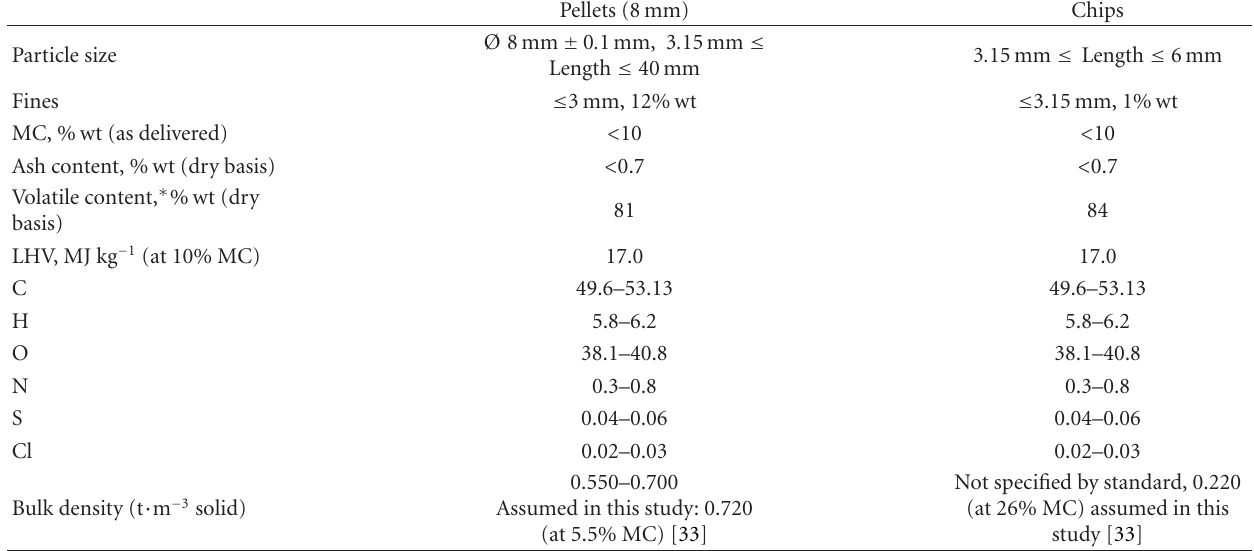
Table 1: Properties of pellets and chips according to standard [16] and the Fuel Handbook [55]. MC: moisture content, LHV: lower heating